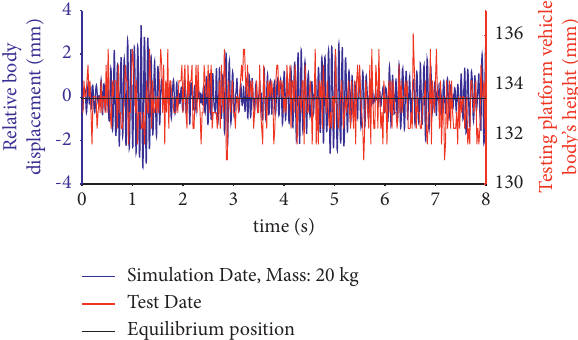
Figure 13: Test and simulation time-domain results of the vehicle’s body height and relative displacement under 20kg